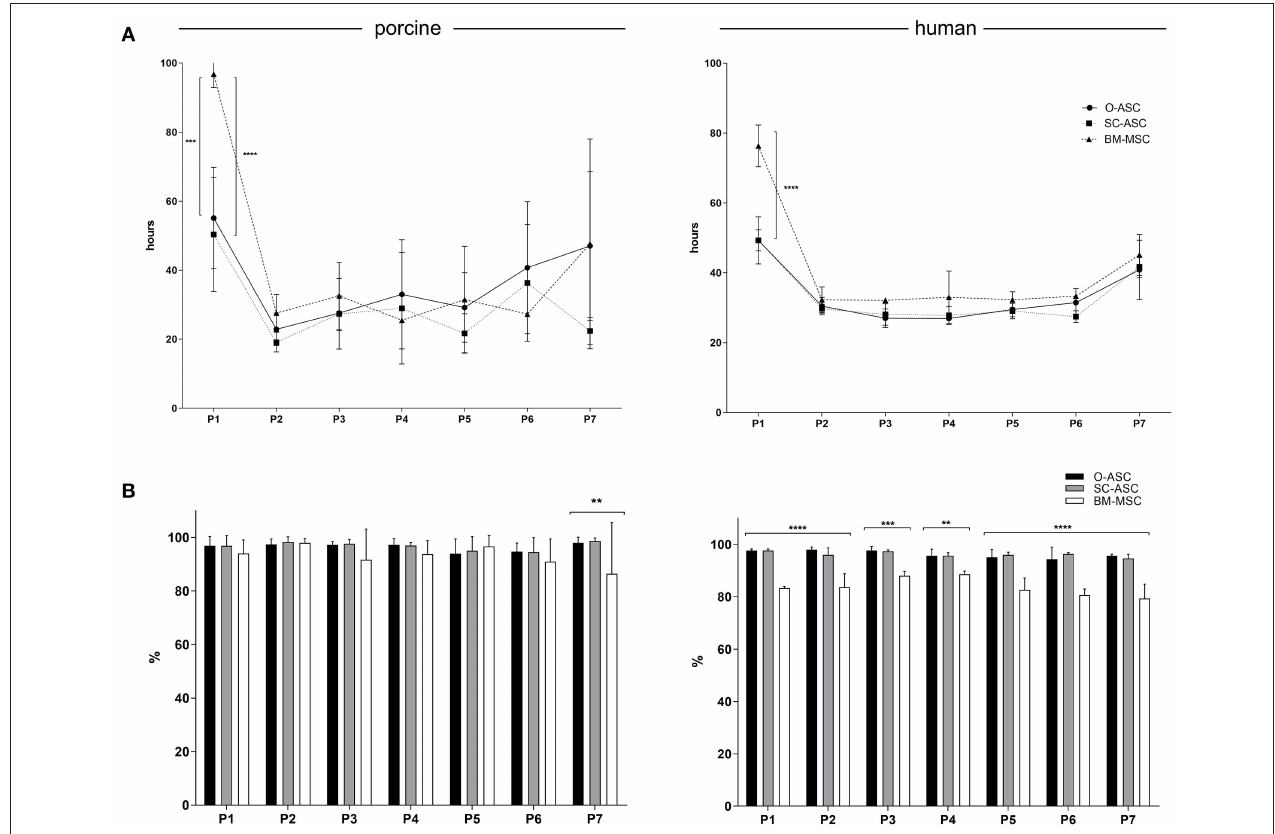
FIGURE 2 | Cell culture. (A) Population doubling times (PDT) are shown for the three cell lines (O-ASC, SC-ASC, and BM-MSC) over 7 passages. Median ± interquartile range, expressed in hours. (B) The cell viability is displayed up to passage 7 for the three porcine and human cell lines (O-ASC, SC-ASC and BM-MSC) during culture with endothelial growth medium (EGM-2MV, Lonza). Determined by Tryptan blue exclusion. Cells lifted at 80–90% confluency. Expressed in %. Error bars = SD. One-way ANOVA with Tukey post-test. ** p < 0.01, *** p < 0.001, **** p < 0.0001.